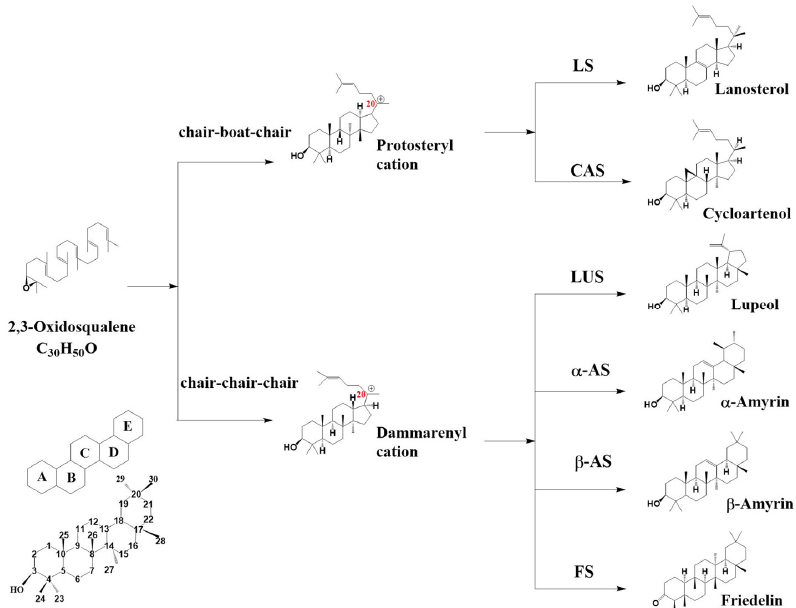
Figure 1. OSC catalyzes 2,3-oxidosqualene to produce different skeletons through two conformations. LS, lanosterol synthase; CAS, cycloartenol synthase; LUS, lupeol synthase; α -AS, α -amyrin synthase; β -AS, β -amyrin synthase; FS, friedelin synthase.